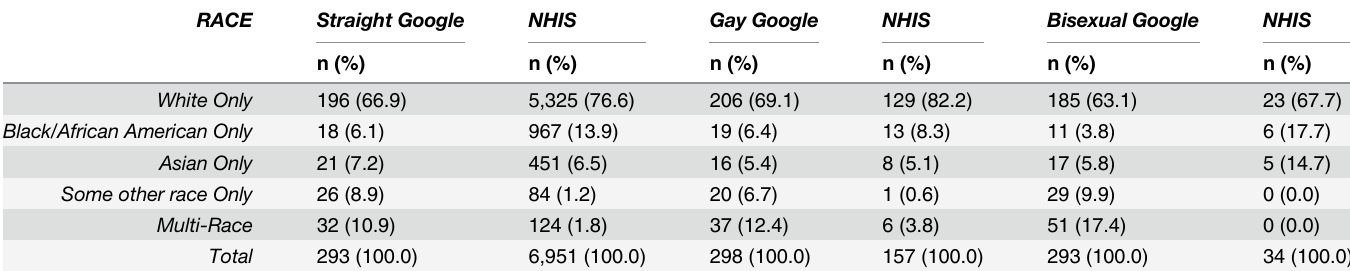
Table 6. Google Android Panel Samples and the NHIS Reported Race for Men by Sexual Orientation.